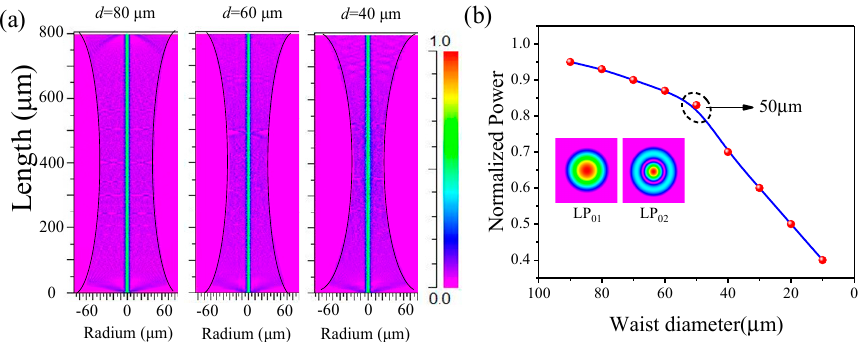
Figure 2. ( a ) The light field distributions and ( b ) the normalized energy with the varied d .